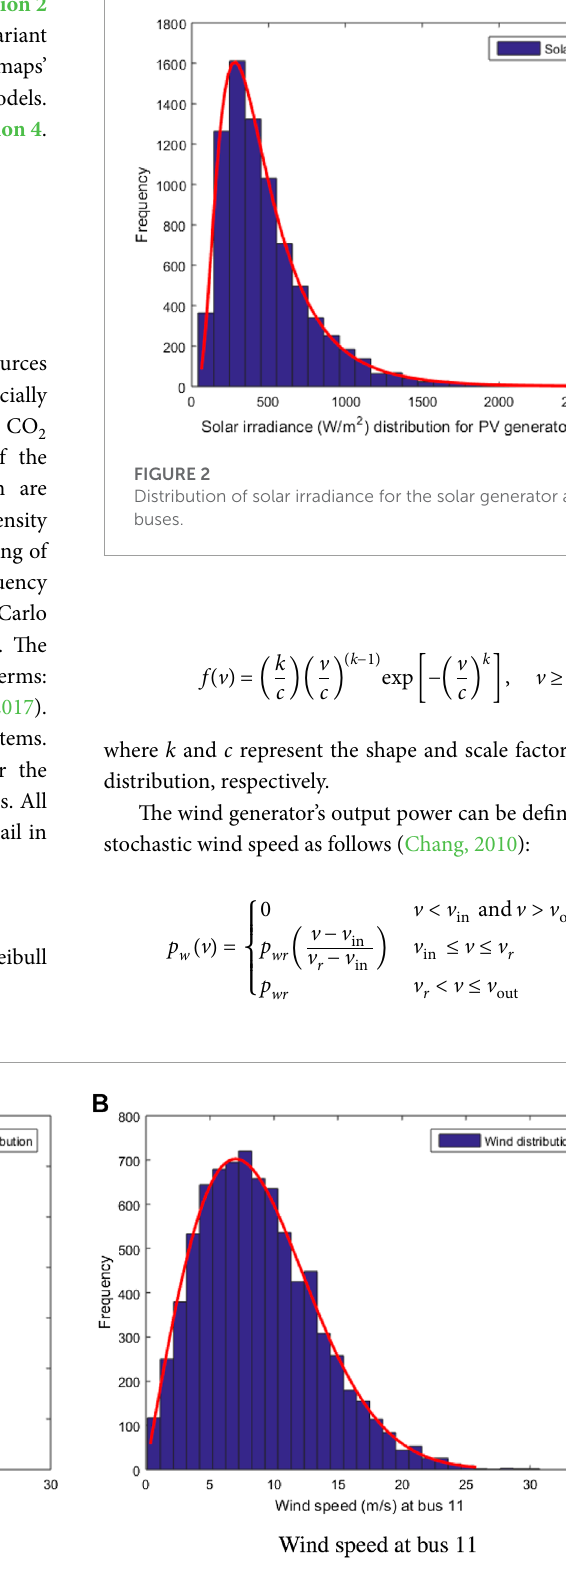
FIGURE 1 Distribution of wind speed for wind generators. (A) Wind speed at bus 5 and (B) wind speed at bus